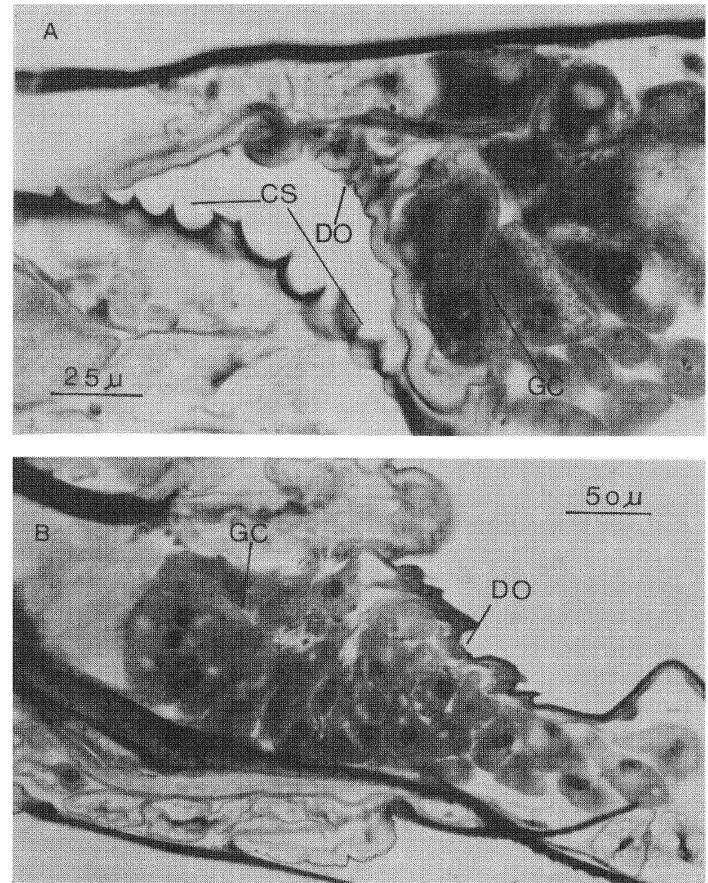
Fig. 2 A. Longitudinal section through pygidial gland of Novomessor albisetosus 6’. B. Longitudinal section through subgenital plate gland of N. albisetosus 6’- CS cuticular structure; GC=glandular cells; DO=openings of glandular